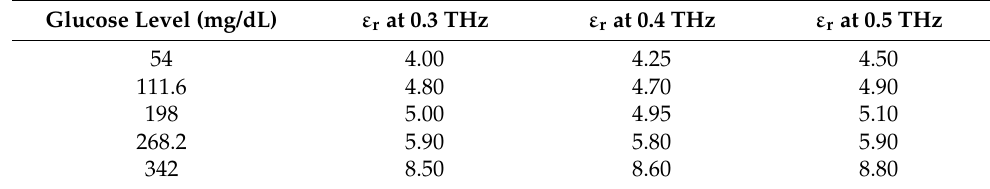
Figure 1. Geometrical schematic of the resonator: ( a ) 3D representation showing the analyte top coating layer with the incidence angle ( θ ) and ( b ) 2D of the symmetric complementary split rectangular resonators with the related dimensions, respectively. The inset illustrates the field polarization. Table 1. The dielectric constant of the sample